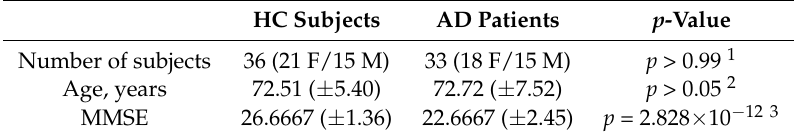
Table 1. Demographic and neuropsychological characteristics of the